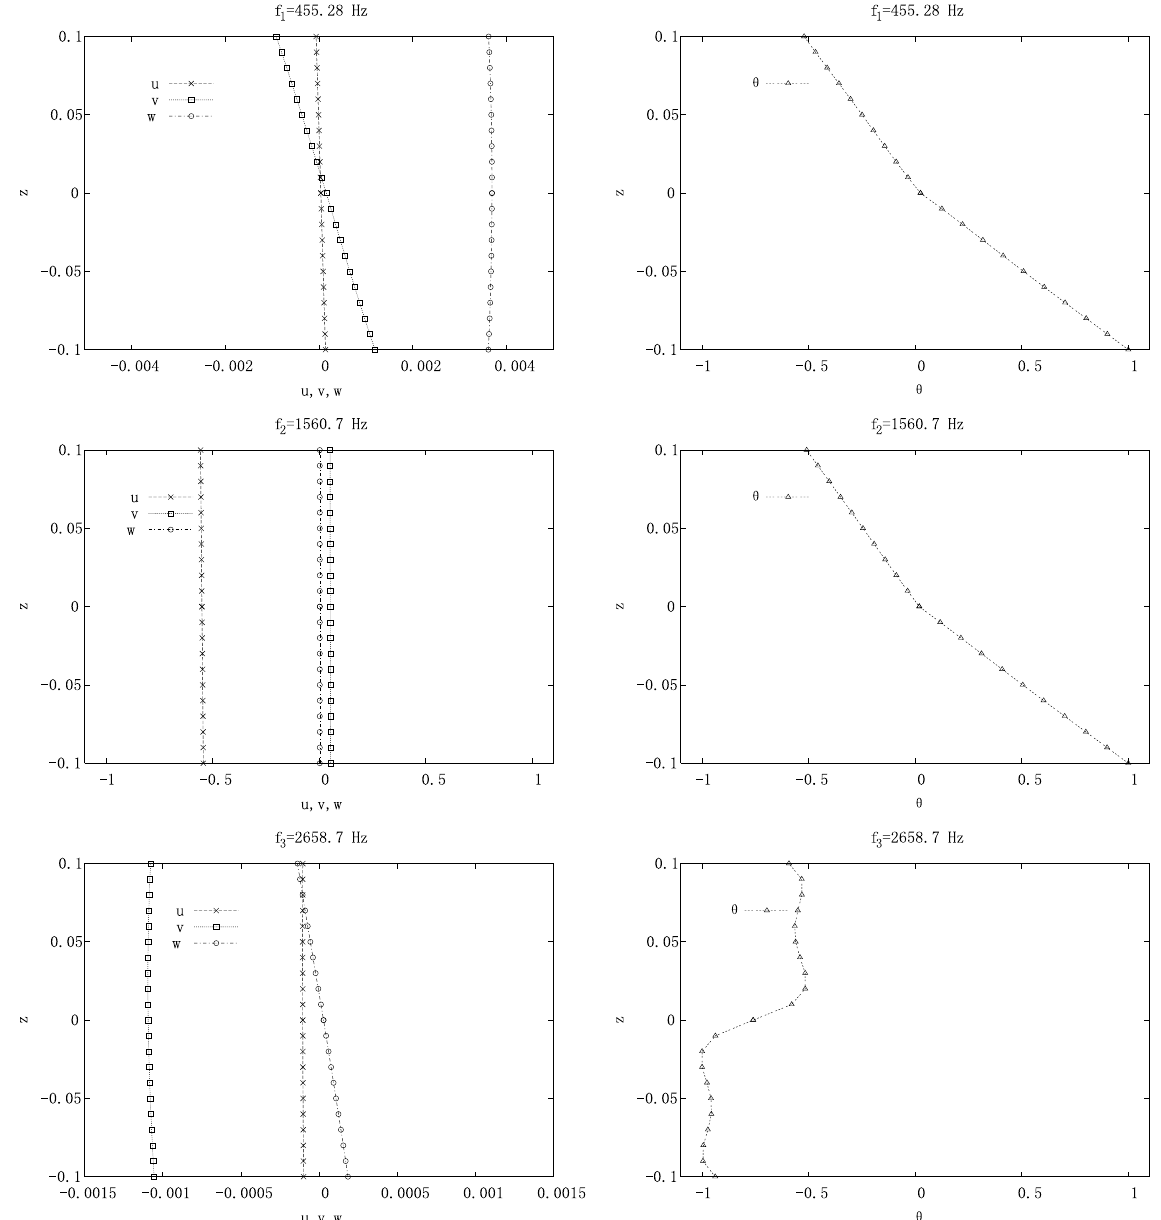
Fig. 6. Two-layered isotropic shell, m = n = 1 and R α /h = 50. First three modes in terms of displacements and sovra-temperature. LD4(TM) model. ( m , n ) and on the layers stacking, the coupling effect depends on the considered mode in terms of displacement and sovra-temperature. The use of re fi ned theories, such as LD4, is mandatory for such an investigation. CLT and FSDT unfortunately lose some modes because of their reduced number of degrees of freedom. There are some frequencies which correspond to a particular vibration mode, where there is no thermo-mechanical coupling. This fact is clearly seen in Figs 5 and 6 for the case of one-layered and two-layered shells, respectively. Figures 5 and 6 give the fi rst three vibration modes in terms of displacement components and sovra-temperature. The fi rst three frequencies are given for thickness ratio R α /h = 50 and m = n = 1. For bending modes (related to f 1 and f 3 ), there is